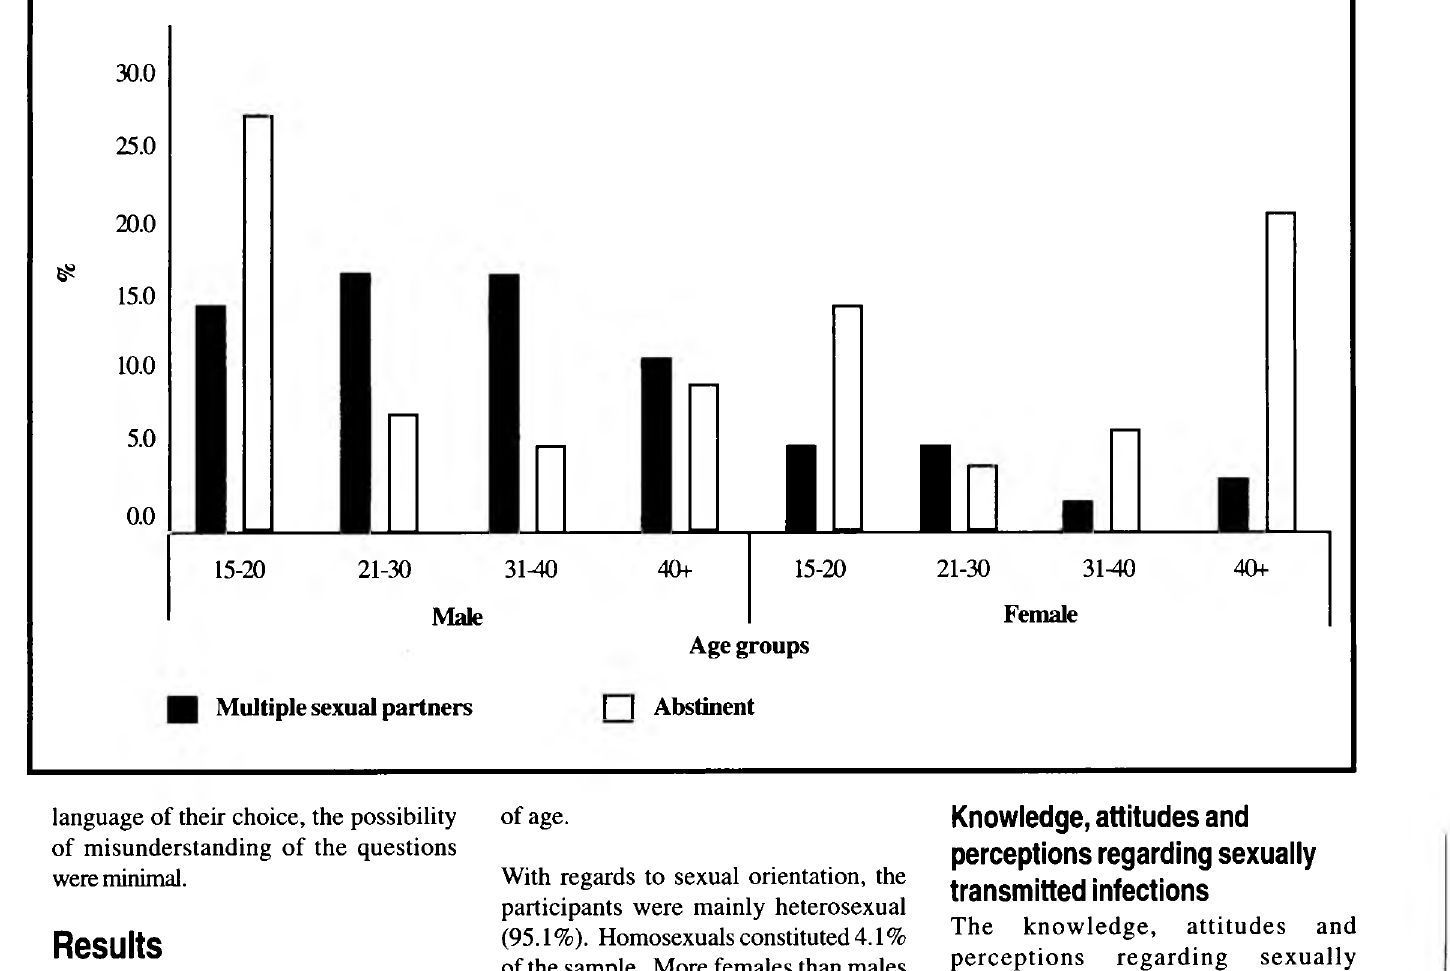
FIGURE 1: Age and multiple sexual partners or abstinence